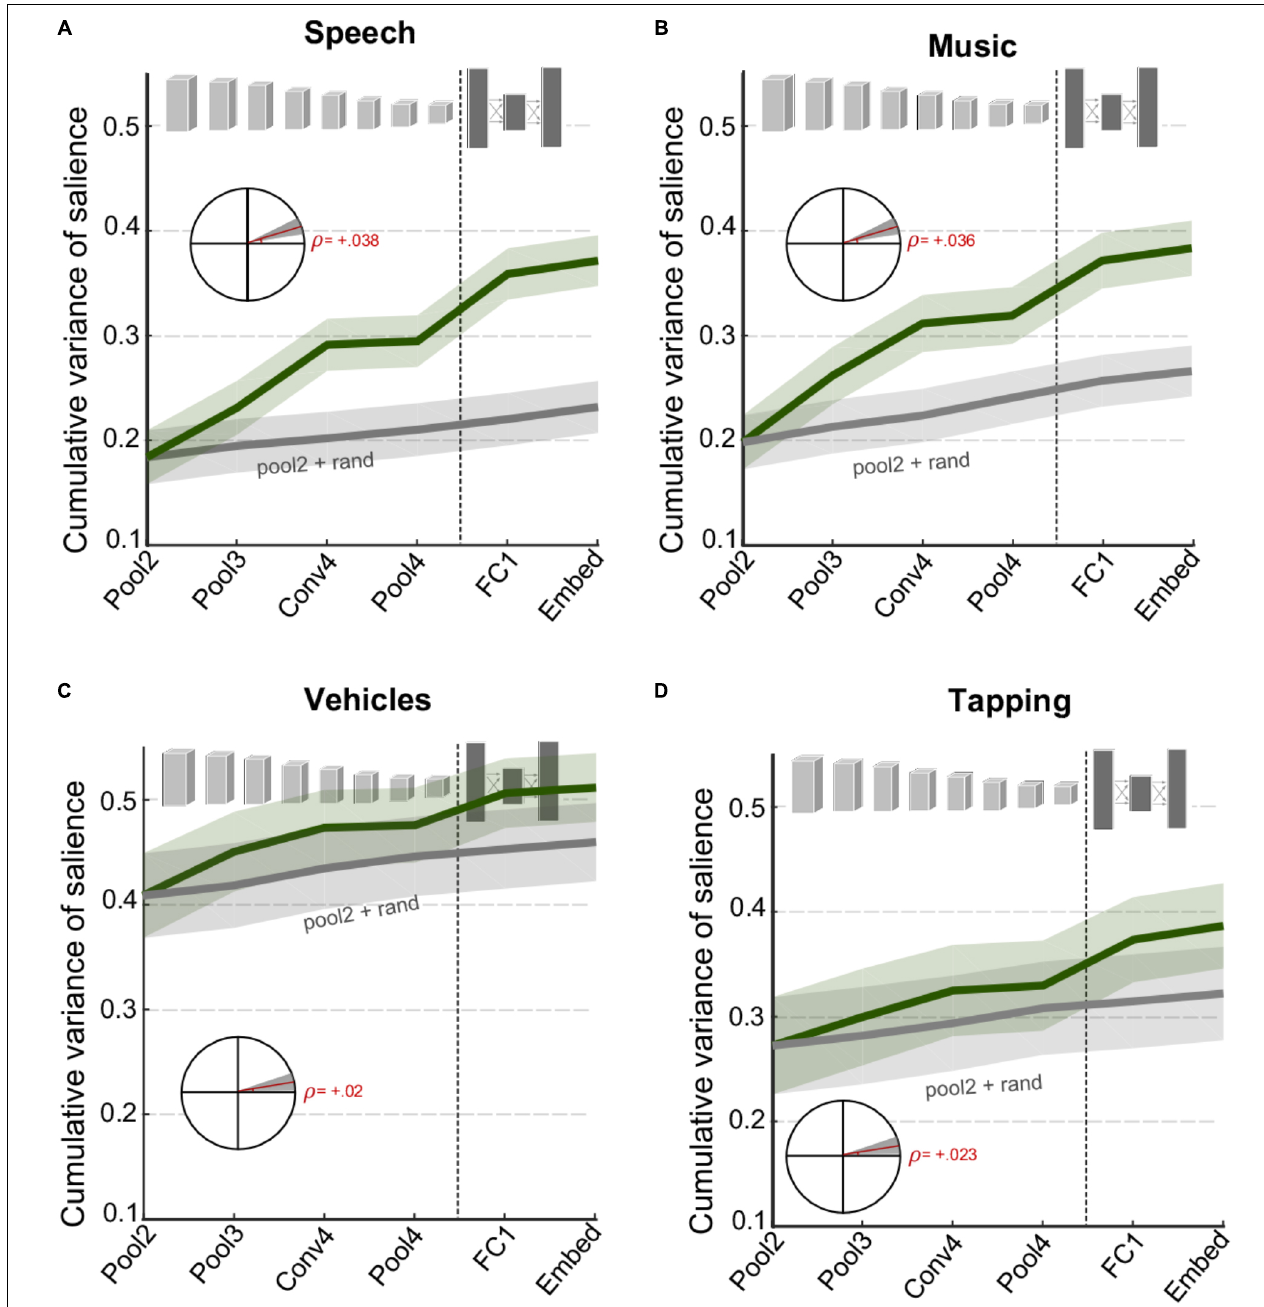
FIGURE 4 | Cumulative variance explained after including successive layers of the CNN for specific categories of events (A) speech events, (B) music events, (C) vehicle events, and (D) tapping/striking events. The gray line shows a baseline level of improvement estimated by using values drawn randomly from a normal distribution for all layers beyond Pool2. For all panels, shaded areas depict ± 1 SEM. Insets show the slope of the trend line fitted with linear regression, with shaded areas depicting 99% confidence intervals of the slope.